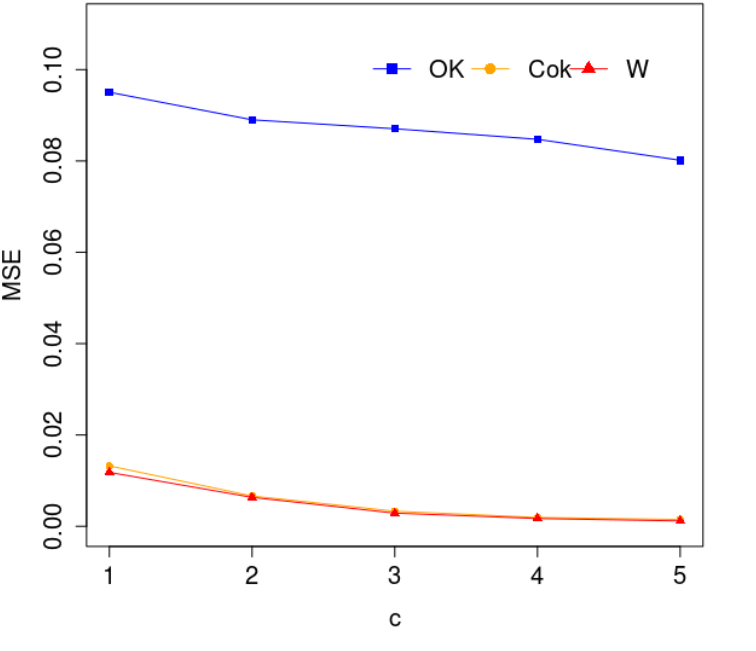
Figure 6. The mean MSE of the three schemes varies with the amount of